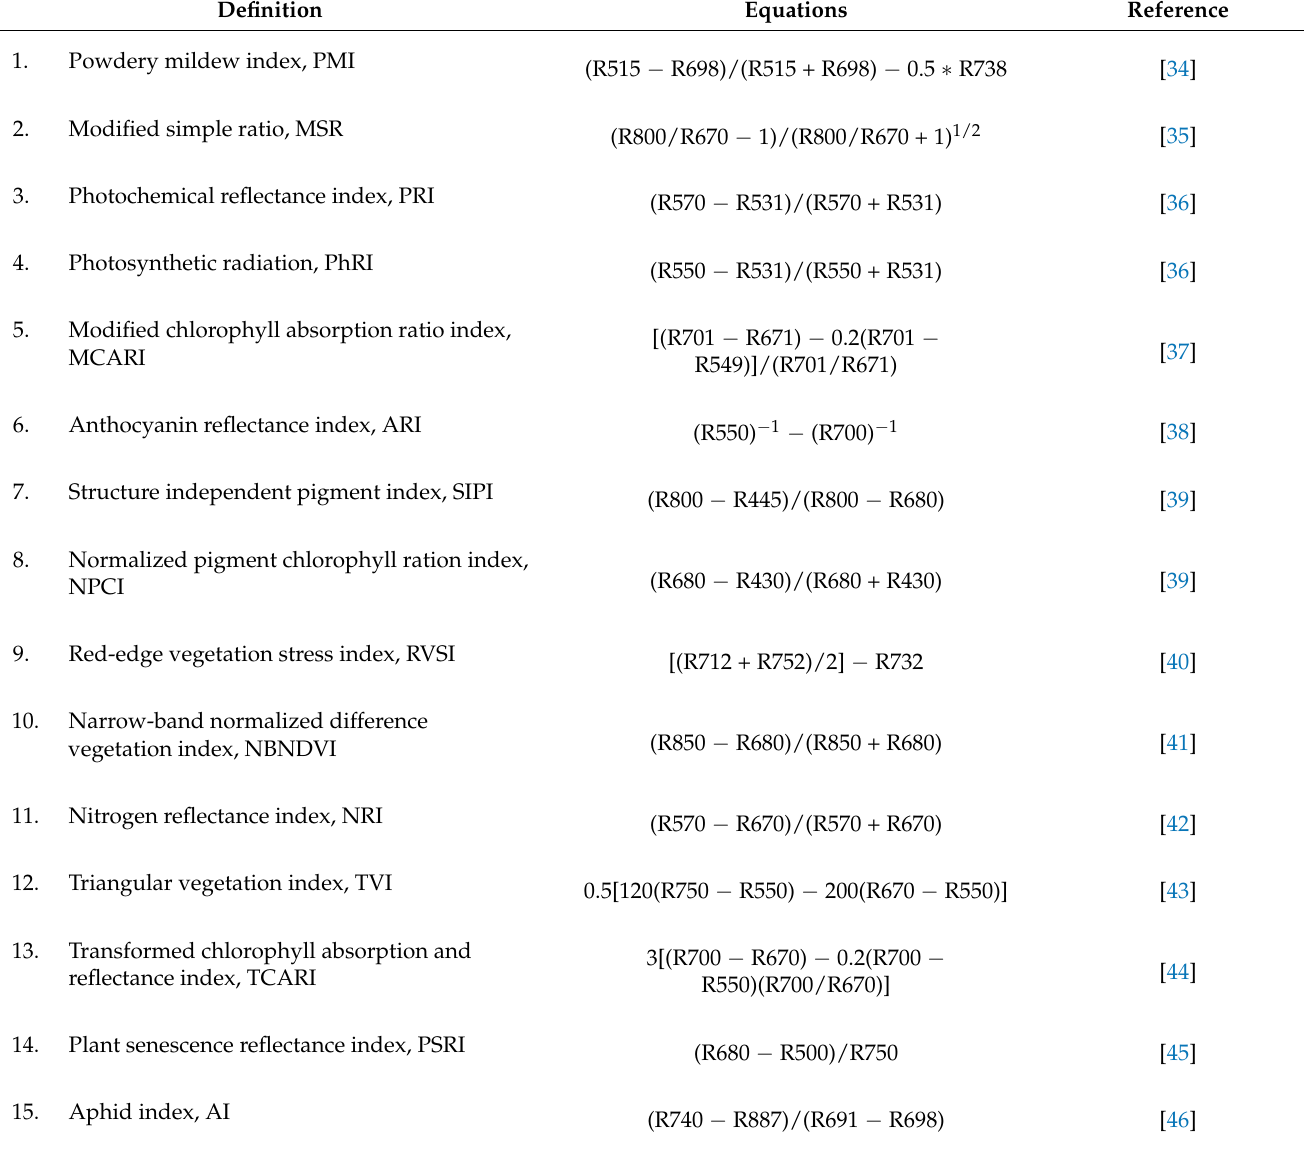
Table 2. Vegetation indices used in this